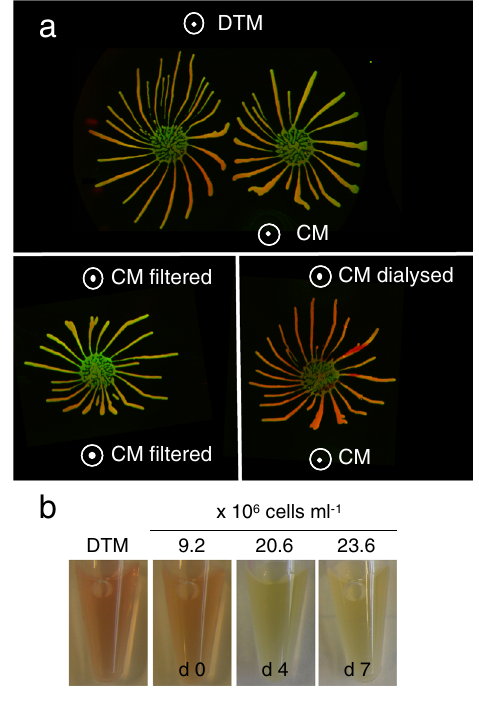
Fig. 1 Response of migrating cells to fresh medium (DTM) and conditioned medium (CM) after different treatments. a Upper panel: communities exposed to DTM and CM; lower left panel: communities exposed to fi ltered CM on both sides; lower right panel: communities exposed to dialysed CM (12kDa cut-off) or undialysed CM. White circles with dots indicate where solutions were pipetted onto the plates. Community lifts stained for EP (green) and GPEET (red) are shown. b Continuous growth in liquid culture acidi fi es medium. Representative pictures of culture supernatants from early procyclic forms (EATRO1125) grown in DTM for 7 days without dilution. Left, DTM only. Samples were taken on days 0, 4, and 7. The colour change from red to yellow indicates that the culture becomes more acidic with time. Cell titres are